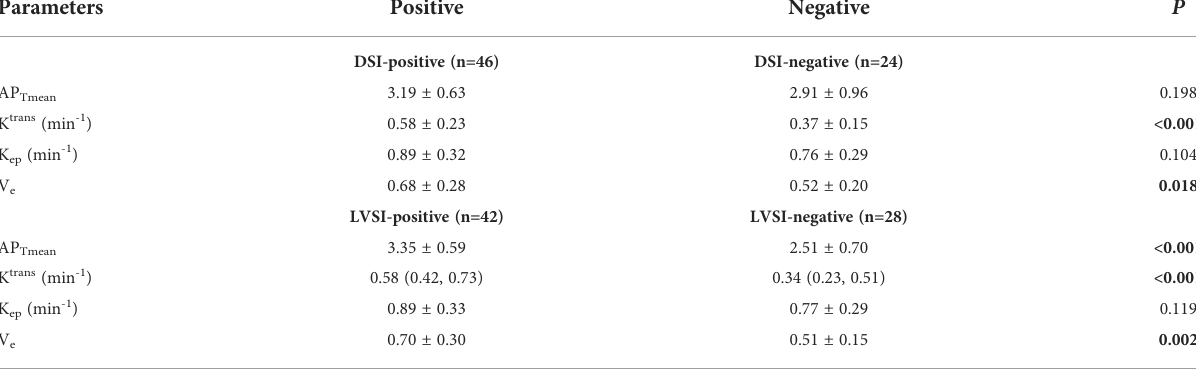
TABLE 3 Comparison of imaging parameters between DSI and LVSI positive and negative groups.